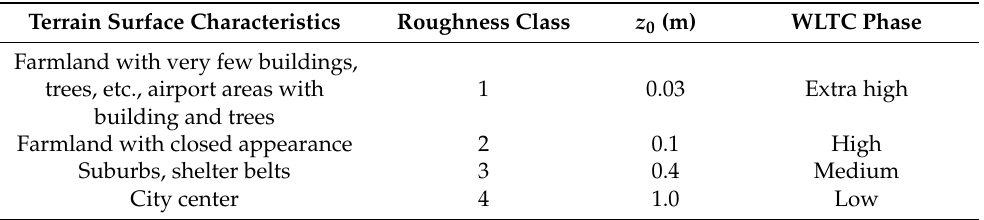
Table 1. Terrain surface characteristics, roughness classes, and roughness lengths for each WLTC phase (data from [35]).